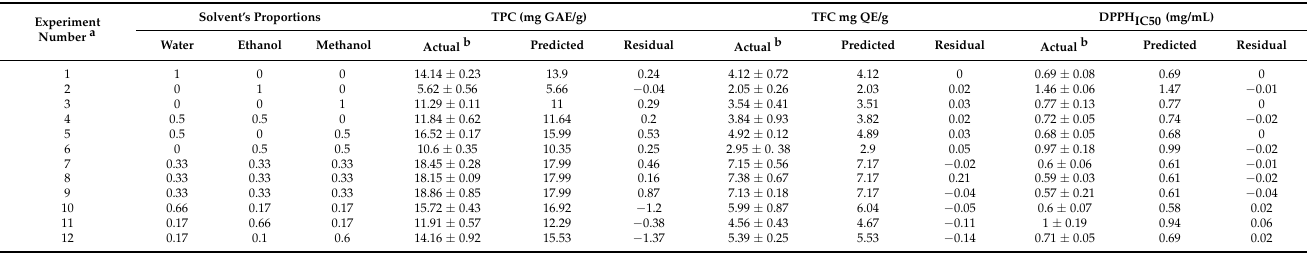
Table 2. Experimental conditions of mixture design, actual and predicted values and residuals for each response.